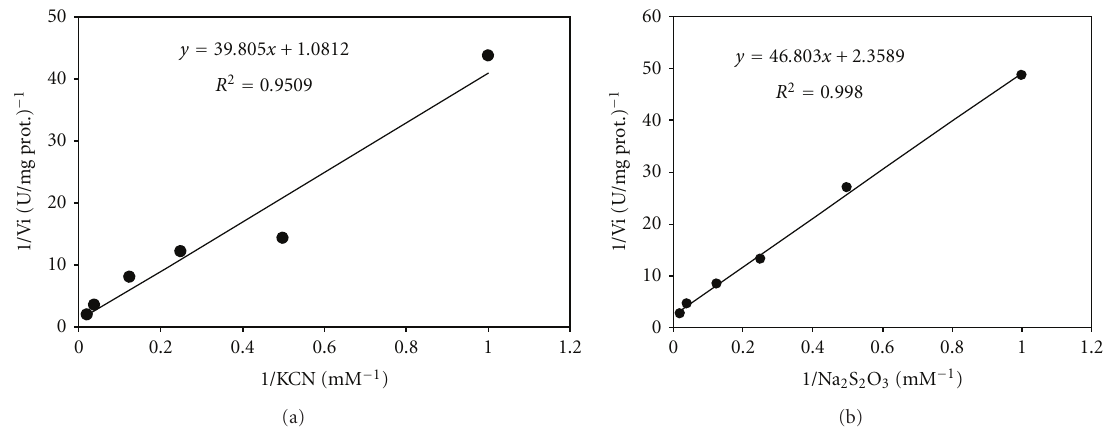
Figure 4: Lineweaver-Burk plot for the determination of the kinetic parameters of rainbow trout rhodanese. The enzyme was assayed at varying concentrations of Na 2 S 2 O 3 at 50mM KCN (a) and varying concentrations of KCN at 50 mM Na 2 S 2 O 3 (b). The reaction mixture consisted of a 25mM citrate-phosphate-borate bu ff er, pH 10.5, and 50 µ L enzyme in a total volume of 1.75 mL at 25 ◦